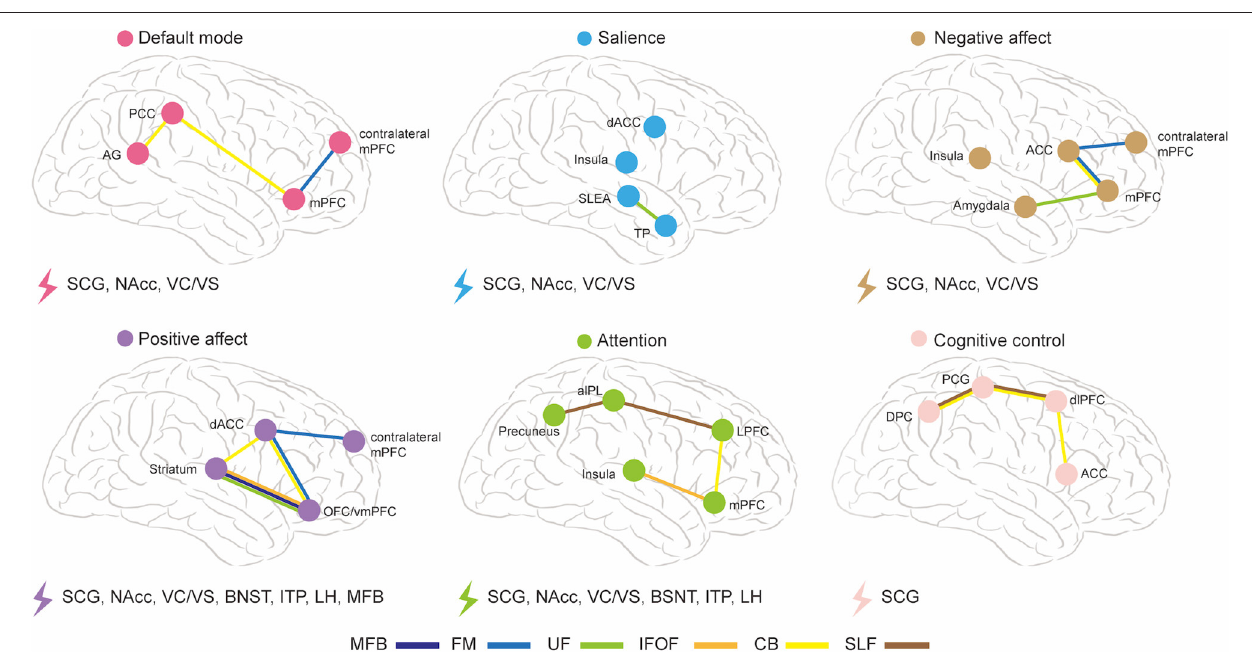
FIGURE 2 | The abnormal WMT in MDD and their implications in different DBS targets and dysfunctional brain circuits. ACC, anterior cingulate cortex; AG, angular gyrus; aIPL, anterior inferior parietal lobule; BNST, bed nucleus of the stria terminalis; CB, cingulum bundle; dACC, dorsal anterior cingulate cortex; dlPFC, dorsal lateral prefrontal cortex; DPC, dorsal parietal cortex; FM, forceps minor; IFOF, inferior fronto-occipital fasciculus; ITP, inferior thalamic peduncle; LH, lateral habenula; LPFC, lateral prefrontal cortex; MFB, medial forebrain bundle; mPFC, medial prefrontal cortex; NAcc, nucleus accumbens; OFC, orbitofrontal cortex; PCC, posterior cingulate cortex; PCG, precentral gyrus; SCG, subcallosal cingulate gyrus; SLF, superior longitudinal fasciculus; TP, temporal pole; UF, uncinate fasciculus; VC/VS, ventral capsule-ventral striatum; vmPFC, ventromedial prefrontal cortex. target modulates cognitive control circuit. In summary, SCG are implicated in all of the dysfunctional brain circuits modulation, Nacc and VC/VS are implicated in modulating most of